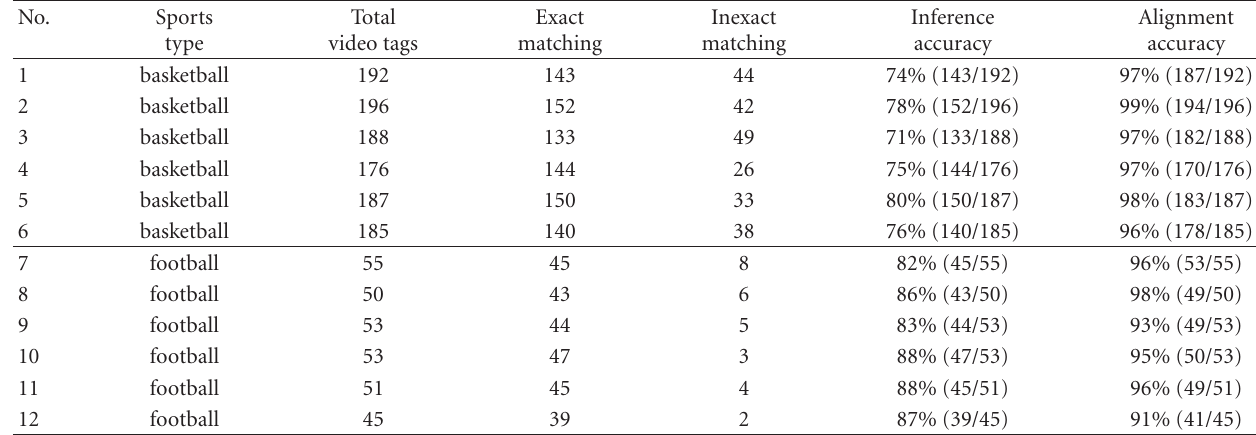
Table 5: Attack-based coarse alignment